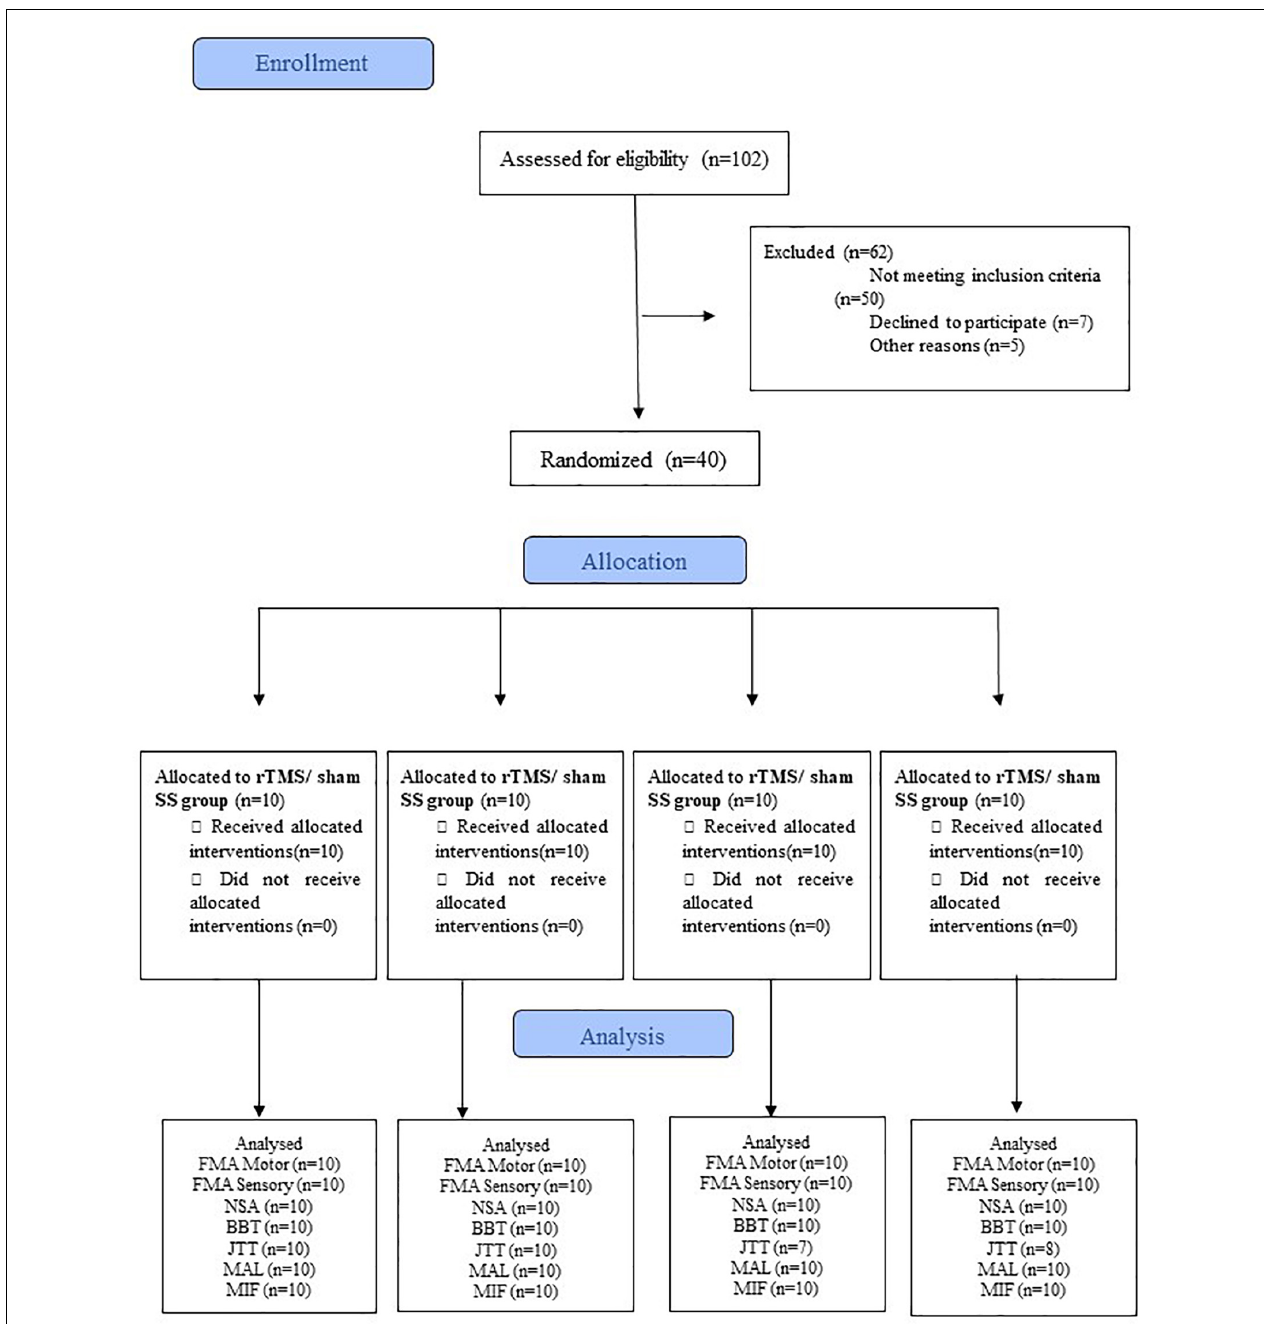
FIGURE 1 | CONSORT flowchart of the study. BBT, Box and Block test; FIM, Functional Independence Measure; FMA-Motor, upper limb Fugl-Meyer for motor function; FMA-Sensory, upper limb Fugl-Meyer assessment for sensory function; JTT, Jebsen-Taylor Hand Function Test; MAL, Motor Activity Long test;. NSA, Nottingham Sensory Assessment; SS, Sensory Stimulation. rTMS, repetitive Transcranial Magnetic Stimulation.